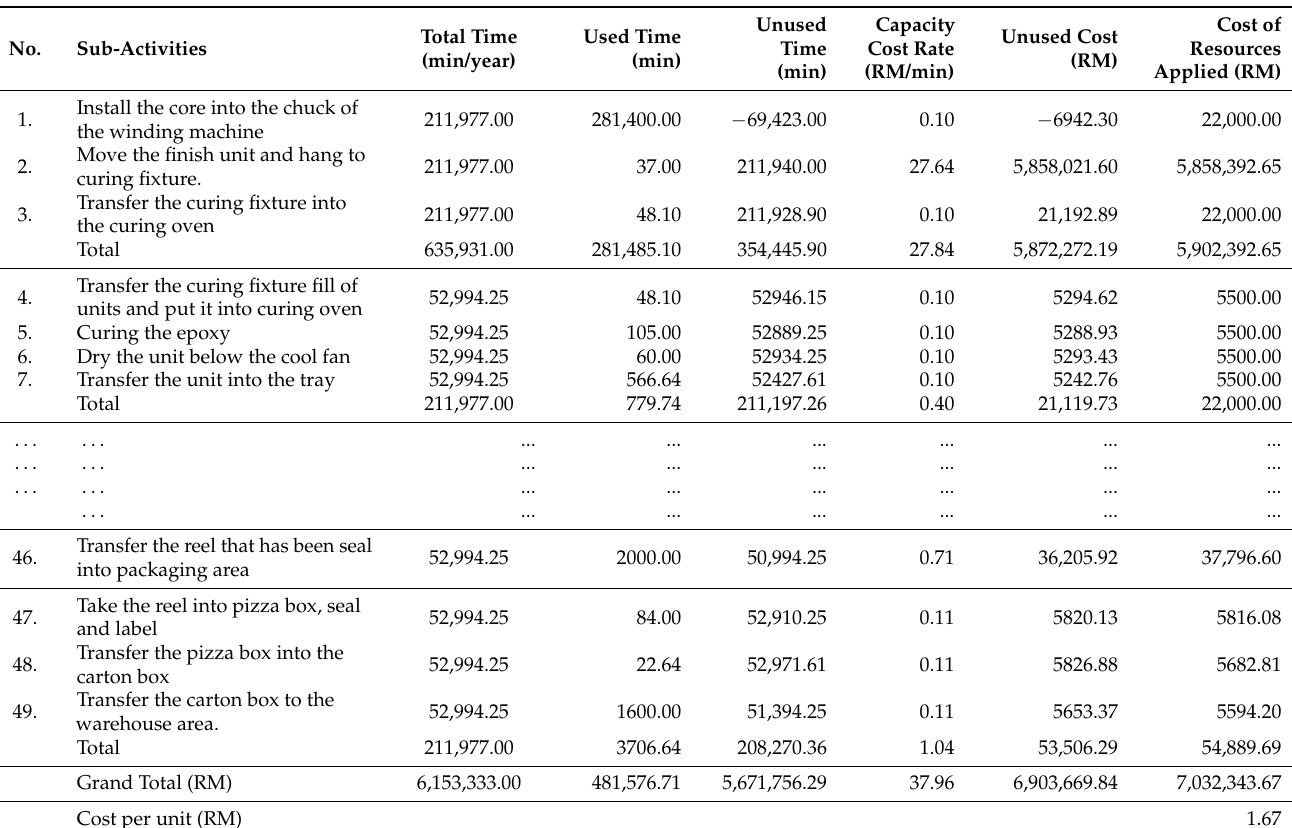
Table 4. Costing structure under integration B.